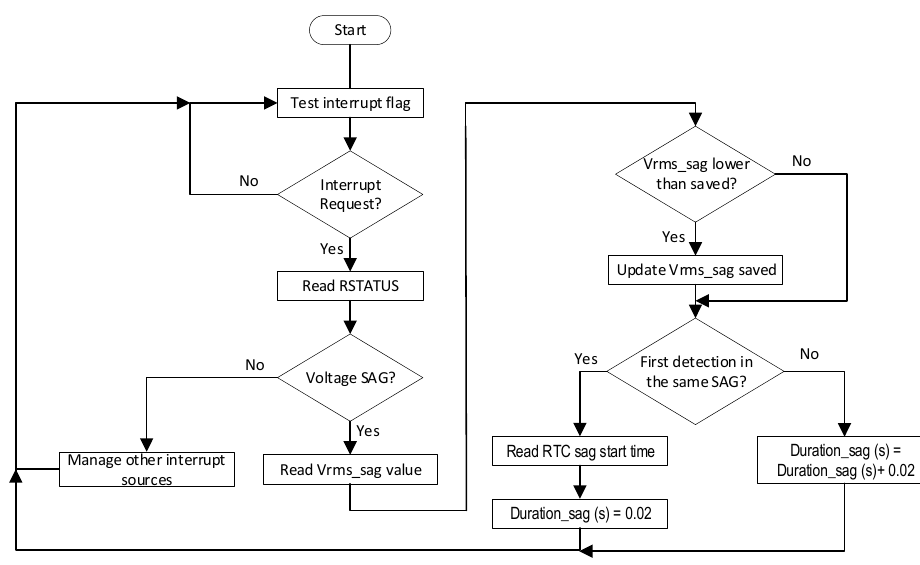
Figure 9. Sag detection process implemented in the MCU.